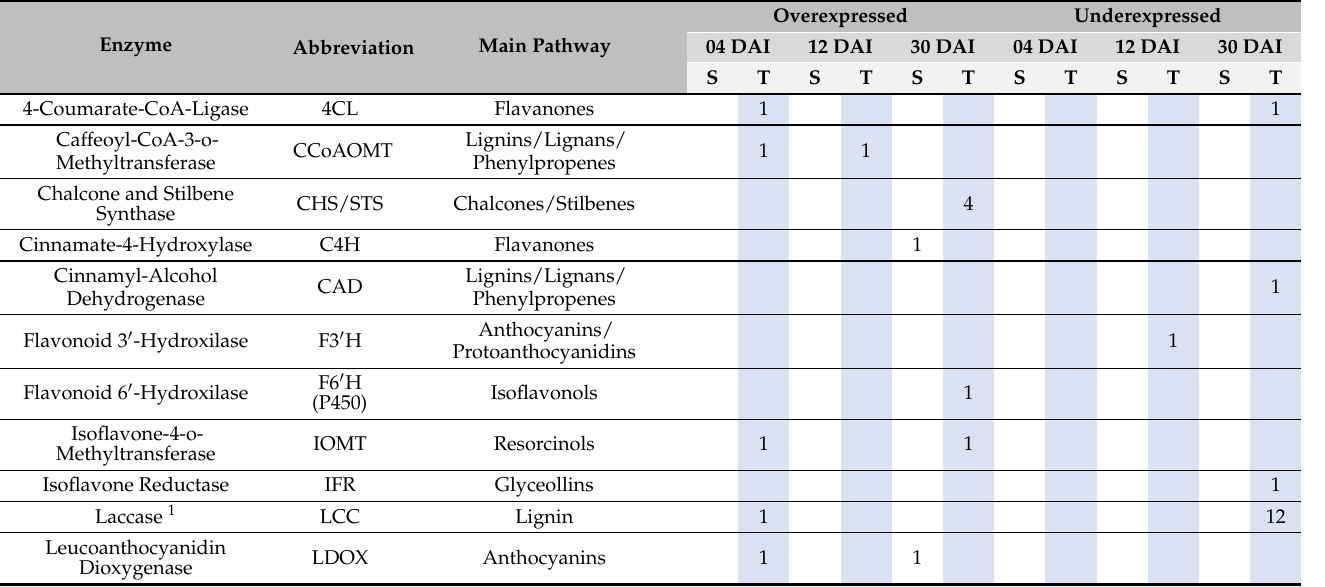
Table 3. Elements of phenylpropanoid-derived metabolic pathways differentially expressed in soybean BRS 133 (S) and PI 595099 (T) genotypes.